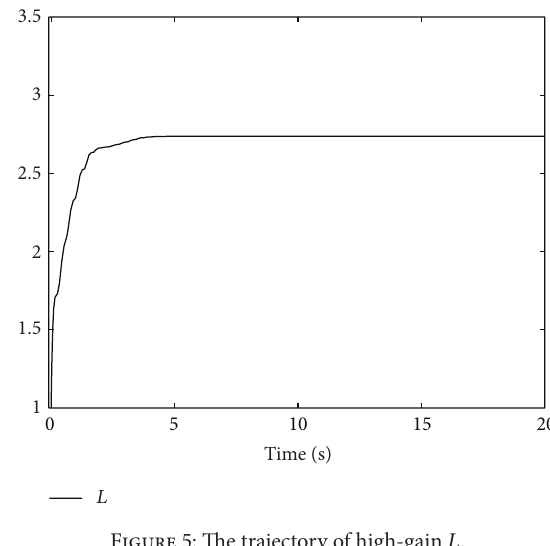
Figure 3: The trajectories of the observer states ̂𝑥 1 and ̂𝑥 2 .